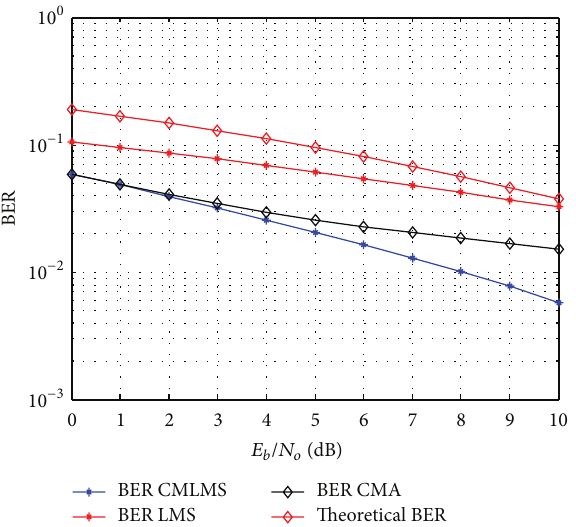
Figure 7: BER performance of CMLMS, LMS, and CMA algo- rithms.